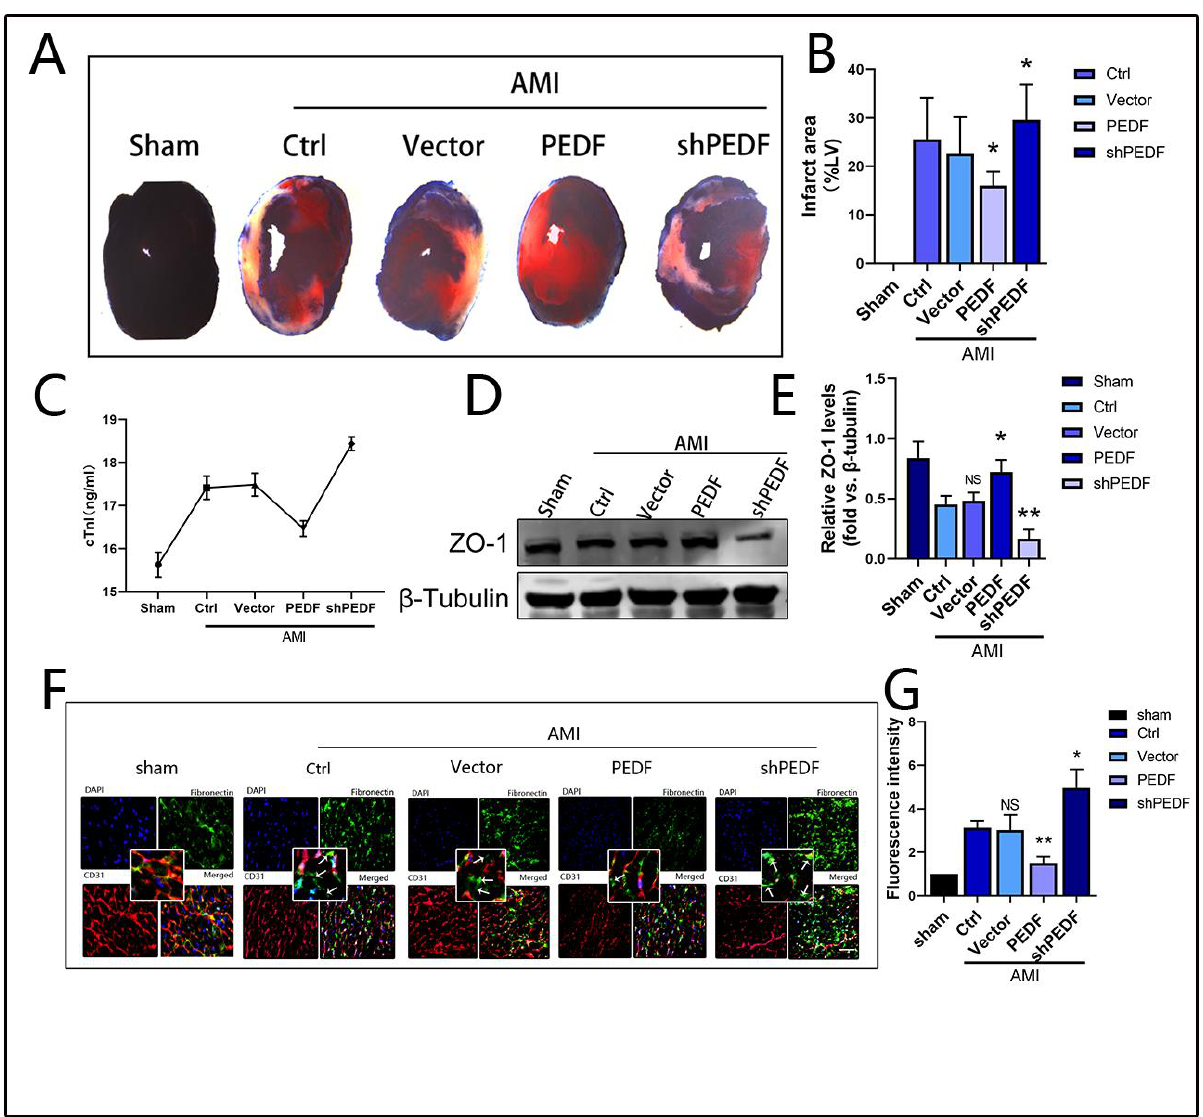
Figure 1. PEDF reduces myocardial infarct size and vascular leakage in AMI rats. ( A ) Representative images of the Evans Blue/TTC staining in myocardial tissues. ( B ) Quantification of myocardial infarct size. ( C ) Quantification of serum cTn-I concentration in rats. ( D , E ) Western blotting to detect the effect of PEDF on the expression of ZO-1. ( F , G ) Immunofluorescence to observe the effect of PEDF on vascular leakage; 15–20 images from each group were used for fluorescence intensity analysis. White arrows point to leakages; Scale Bar = 100 µ m. Data are expressed as mean ± SD; n = 4; NS, no significant difference; * p < 0.05; ** p < 0.01.